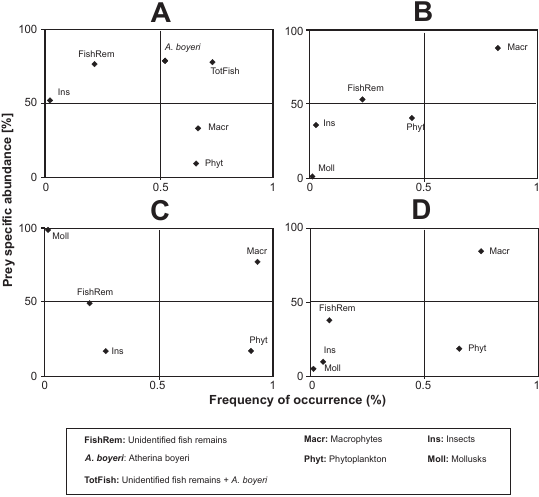
Figure 6. Graphical analysis of Scardinius acarnanicus feed- ing strategy using the modified Costello method in A : Lake Trichonis (with light), B : Lake Trichonis (without light), C : Lake Ozeros, and D : Lake